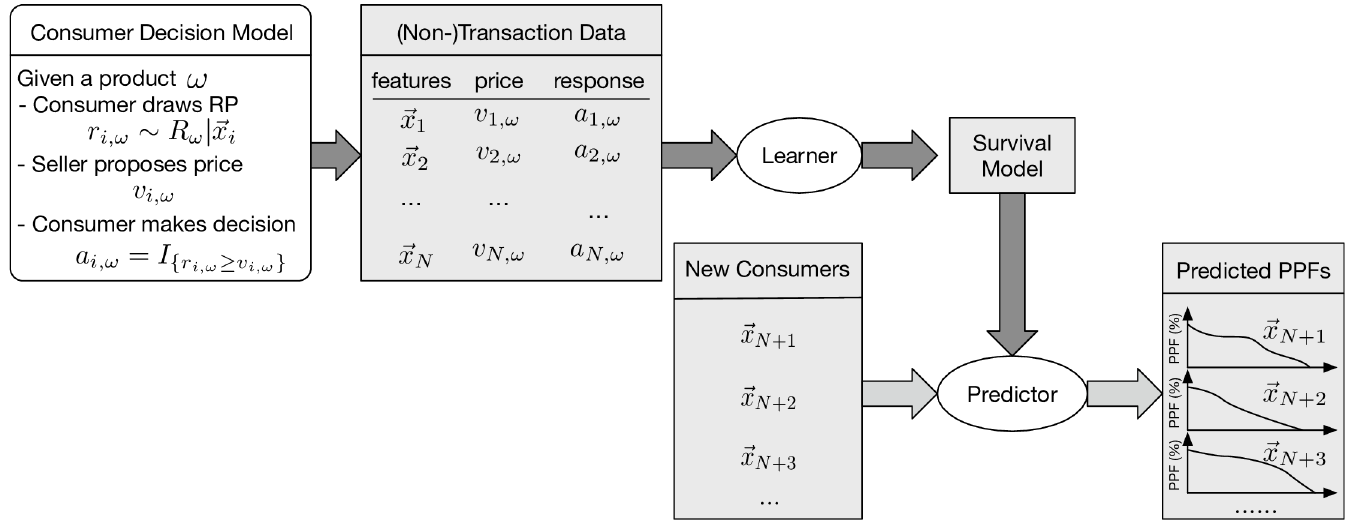
Fig 6. Illustration of the data-generation, learning process and how it works on new instances.